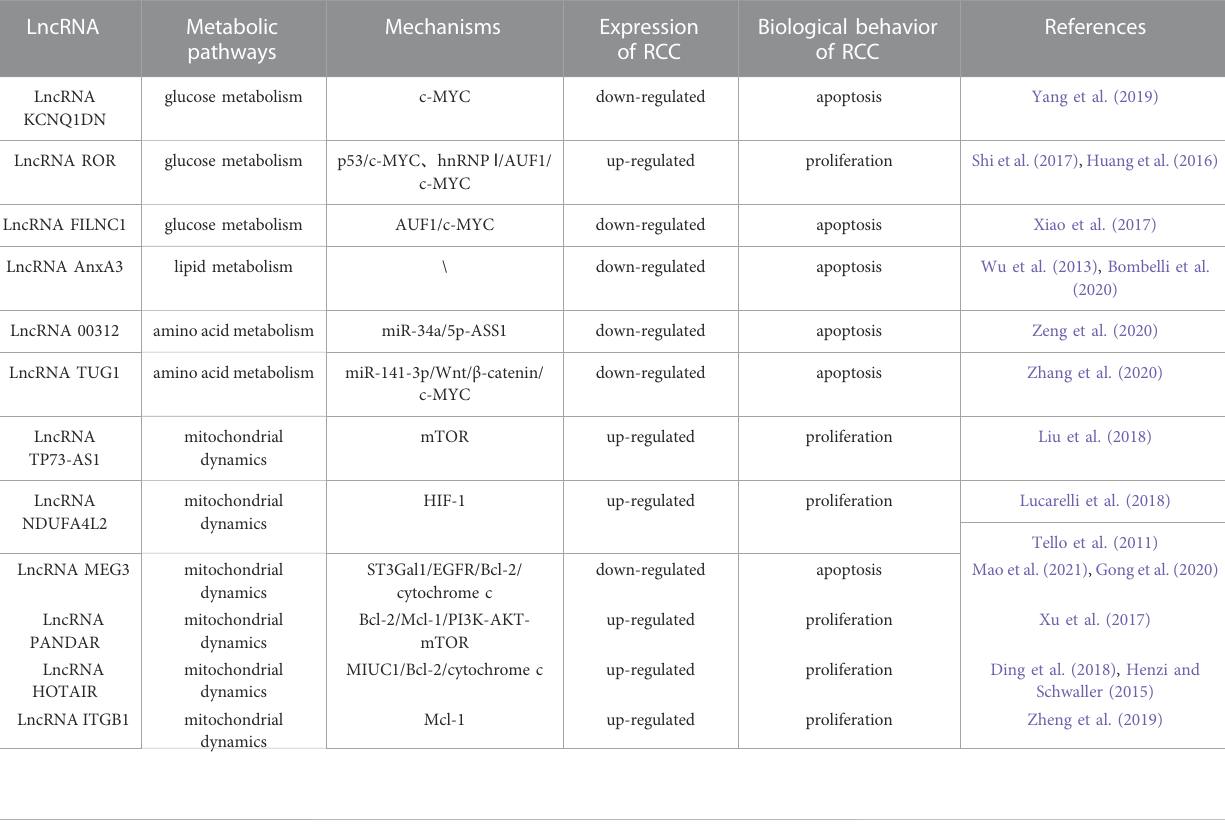
TABLE 2 RCC biological behavior regulated by lncRNAs via metabolic pathways.